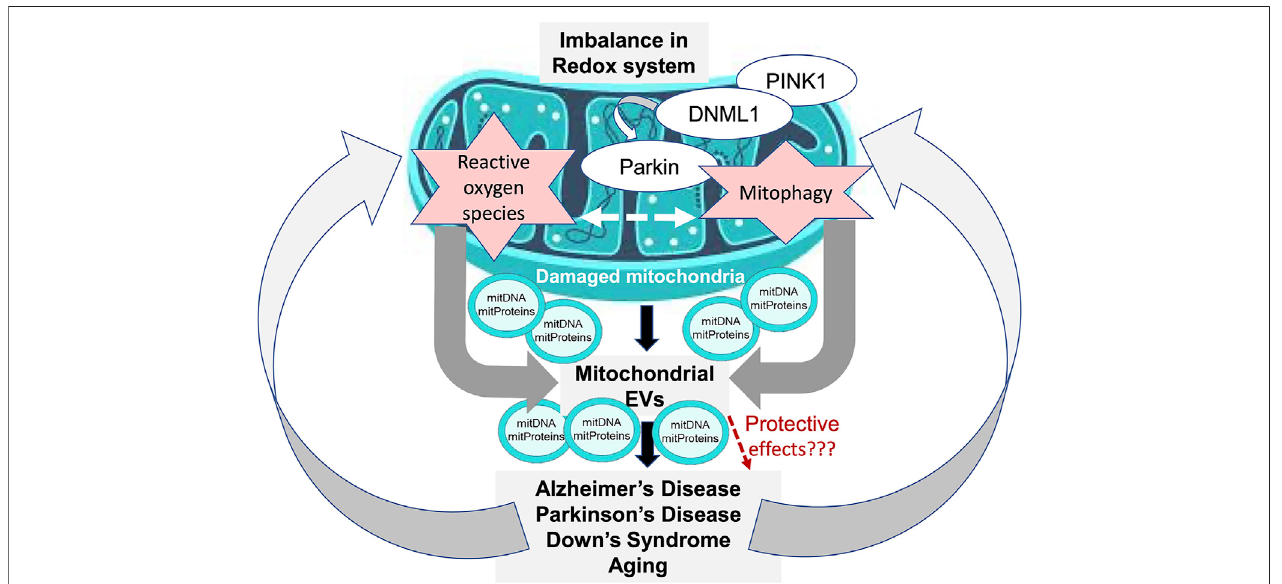
FIGURE 1| Model ofmitochondrial EV involvement in CNS disorders. Dysregulated mitophagy and induction of oxidativestress are associated with mitochondrial dysfunction (MD), which leads to generation of mitochondria-derived vesicles (MDVs) that contain cargo from the damaged mitochondria, including mitochondrial DNA (mitDNA) and mitochondrial proteins (mitProteins). The MDV cargo can be transferred to vesicles that are released extracellularly as a part of the disease pathogenesis and lead to further disease progression. Alternatively, the MDVs may contribute to a protective mechanism by being shuttled to lysosomes for destruction of their